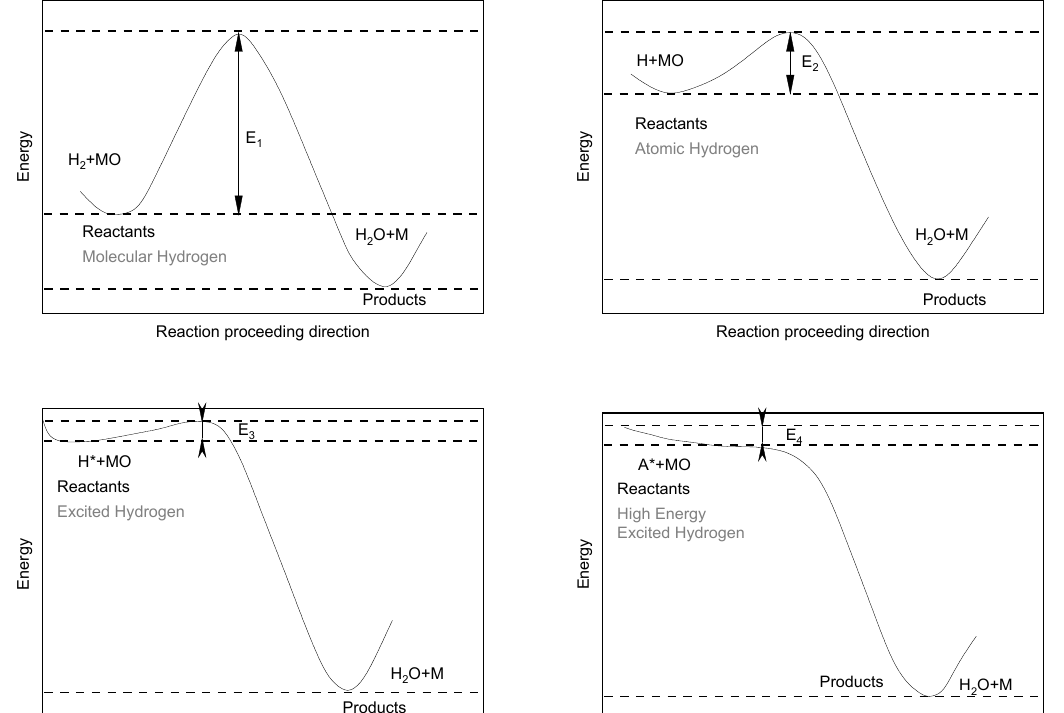
Figure 3. Schematic diagrams for the activation barriers for the different reduction of metal oxides by different hydrogen species [18].